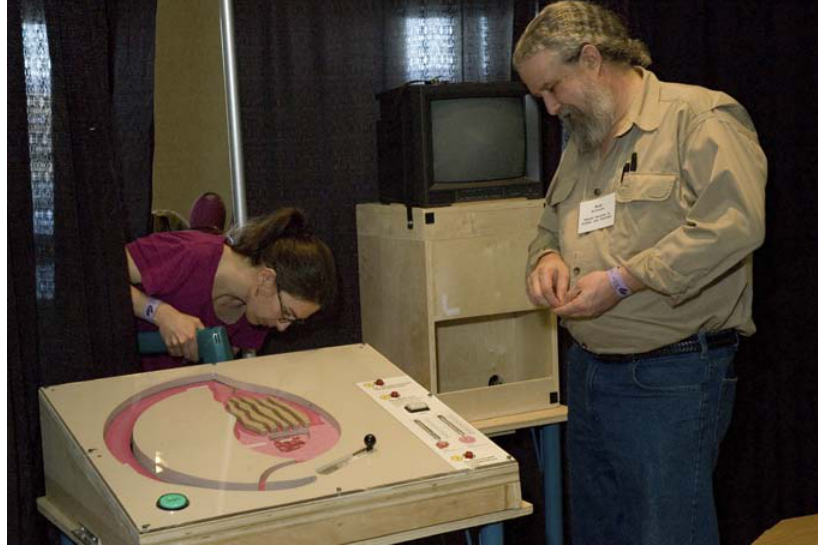
Figure 2. Workshop